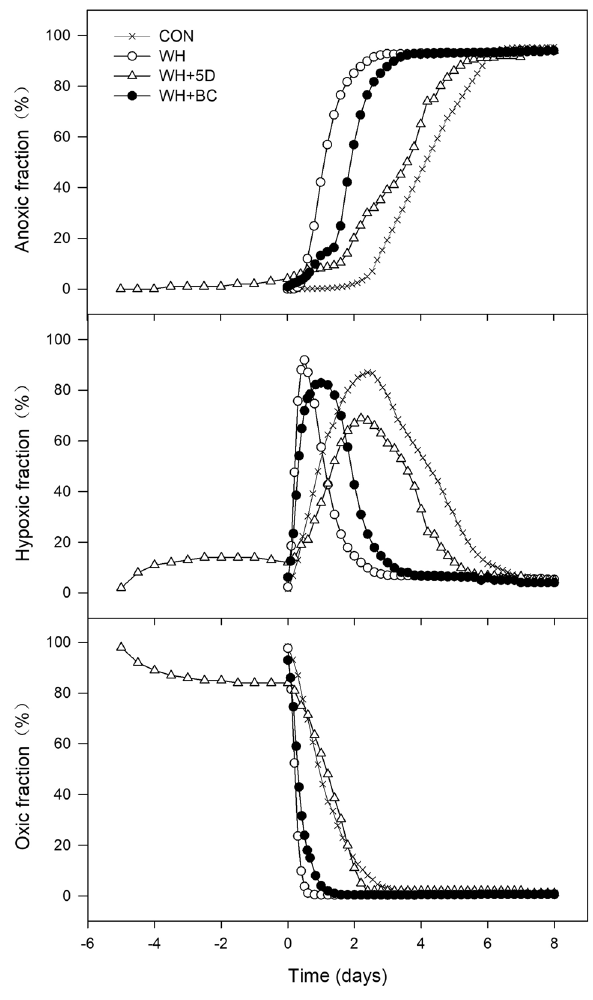
Figure 4. The area fractions of anoxic, hypoxic and oxic conditions (< 0.14, 0.14–2.00, and > 2.00 mg O 2 L −1 respectively) in the soil during the BSD treatment period. CON: soil without any amendments; WH: soil amended with wheat straw; WH + 5D: soil amended with wheat straw 5 days before the BSD treatment; WH + BC: soil amended with wheat straw and